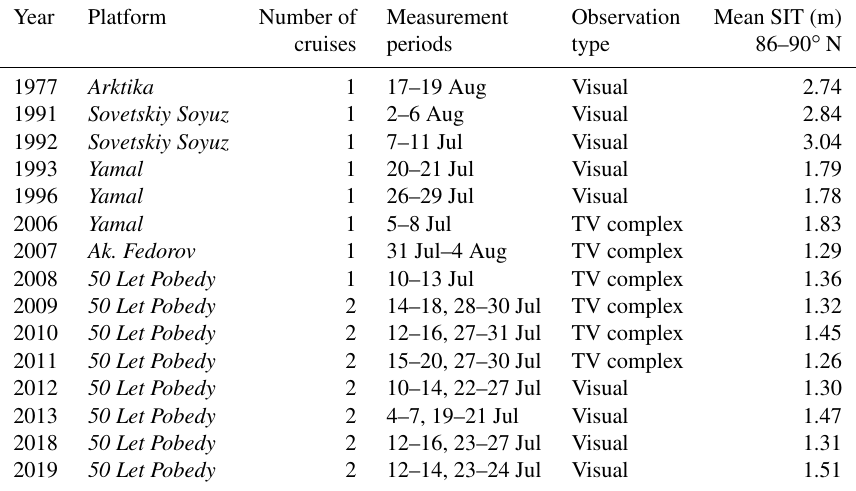
Table 2. Summary of used ships, number of cruises, measurement periods, observation types, and mean sea ice thicknesses (SIT) observed during Russian cruises along the 86–90 ◦ N, 50 ◦ E transect (black line Fig. 1a). Platform Number